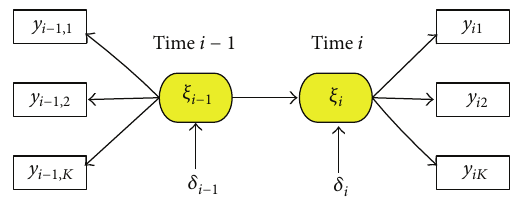
Figure 1: Path diagram about interaction with the latent variables and manifest